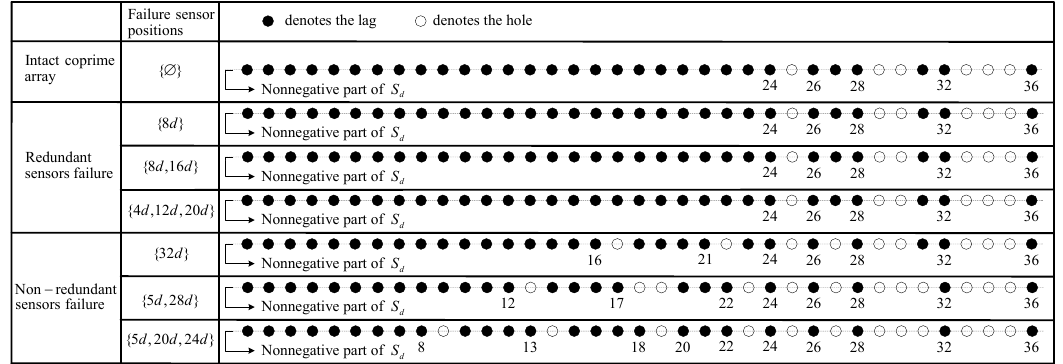
The nonnegative difference coarrays of the co-prime array under different failure scenarios are shown in Figure 3. Three scenarios of redundant sensor failure and three scenarios of non ‐ redundant sensor failure are listed. Comparing the redundant sensor failure scenarios, it can be seen that the number of failed redundant sensors has no effect on the difference coarray. Comparing the non ‐ redundant sensor failure scenarios, it can be seen that the different numbers of failed non ‐ redundant sensors have different effects on the difference coarray. Based on the above analysis, different failure scenarios have different impacts on the difference coarray. Therefore, it is important to diagnose the coprime array and classify the failure scenarios.